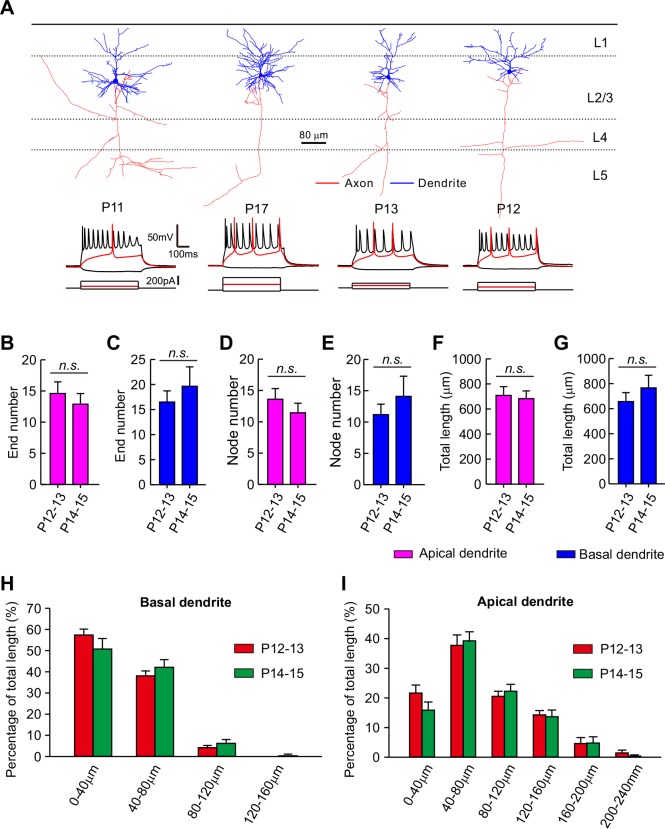
Dendritic morphology of PCs does not change significantly before and after eye opening.(A) The morphological identity of recorded PCs. Top panel, the morphologies of reconstructed PCs. Bottom panel, corresponding membrane responses of PCs to current injections. (B–G) Quantiﬁcation of the end number of apical dendrites (B), the end number of basal dendrites (C), the node number of apical dendrites (D), the node number of basal dendrites (E), the total length of apical dendrites (F), and the total length of basal dendrites (G) between P12–13 (before eye opening) and P14–15 (after eye opening). (H–I) Sholl analysis of dendritic length per 40 μm radial unit distance from the soma. Detailed statistical analysis, detailed data, and exact sample numbers are presented in Figure 1—source data 1.
n.s., p>0.05.